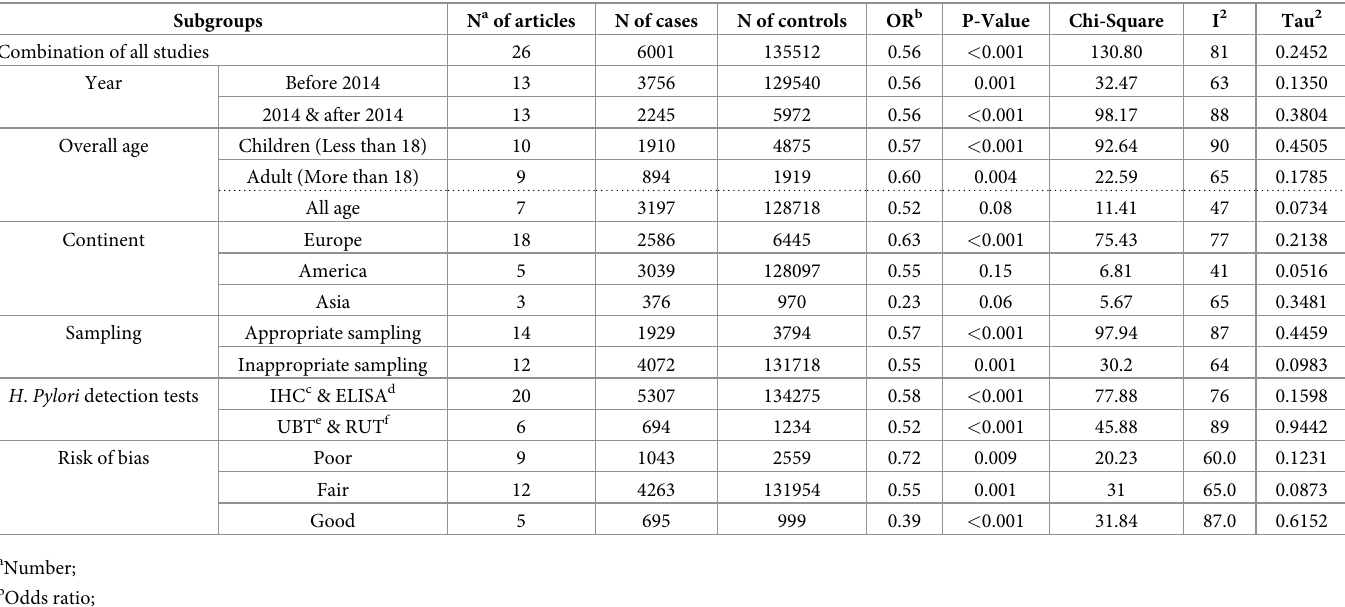
Table 2. Different subgroup analysis by stratifying the